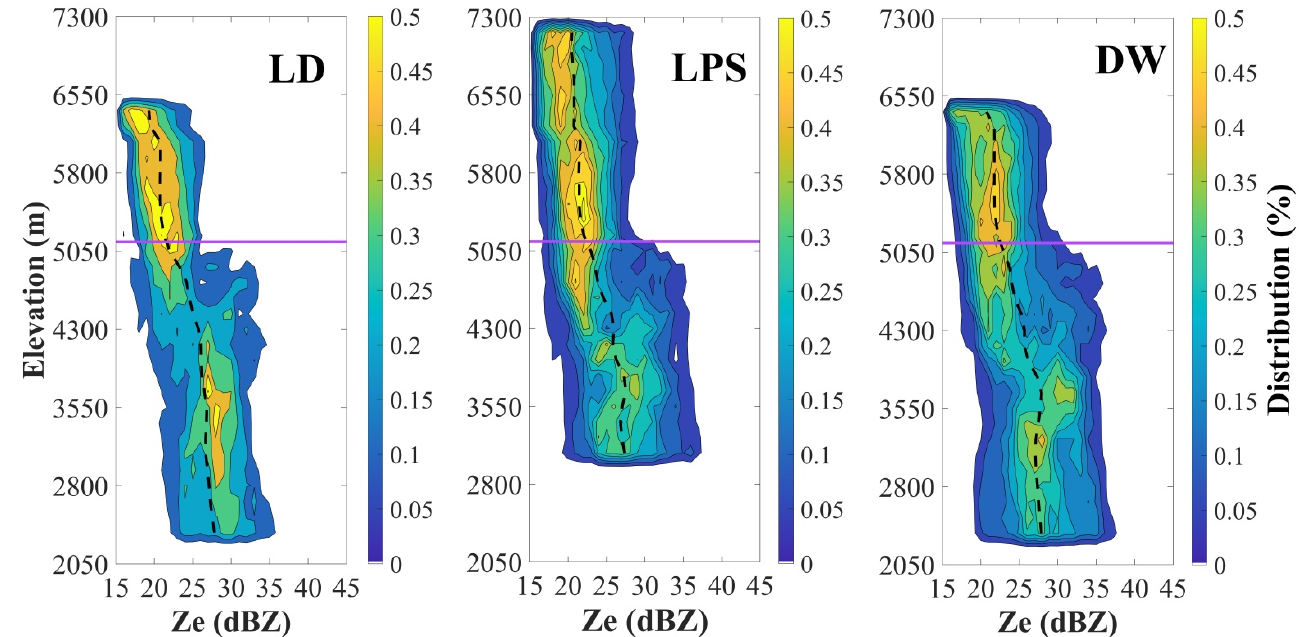
Figure 4. Vertical reflectivity profiles ( Ze greater than 15 dBZ) of stratiform precipitation at the three MRR-2 sites. Contours represent the frequency of occurrence relative to the maximum absolute frequency in the site’s data sample represented in the CFAD, contoured every 10% with the minimum contour level at 5%. The ordinate of the CFAD is altitude (150 m bins) and the abscissa is reflectivity (dBZ). The black dashed line that goes through each panel represents the mean value of reflectivity. The purple solid line represents the mean level of the 0 °C isotherm derived from the RPG at LD. Table 1. Modes of BB characteristics—top height (BB t ), bottom height (BB b ), thickness (BB th ), sharp- ness (BB sh ), peak reflectivity [ Z e (peak) ], and relative peak position ( R peak )—for the stratiform precipi- tation reflectivity profiles measured during May to September 2021 at LD, LPS, and